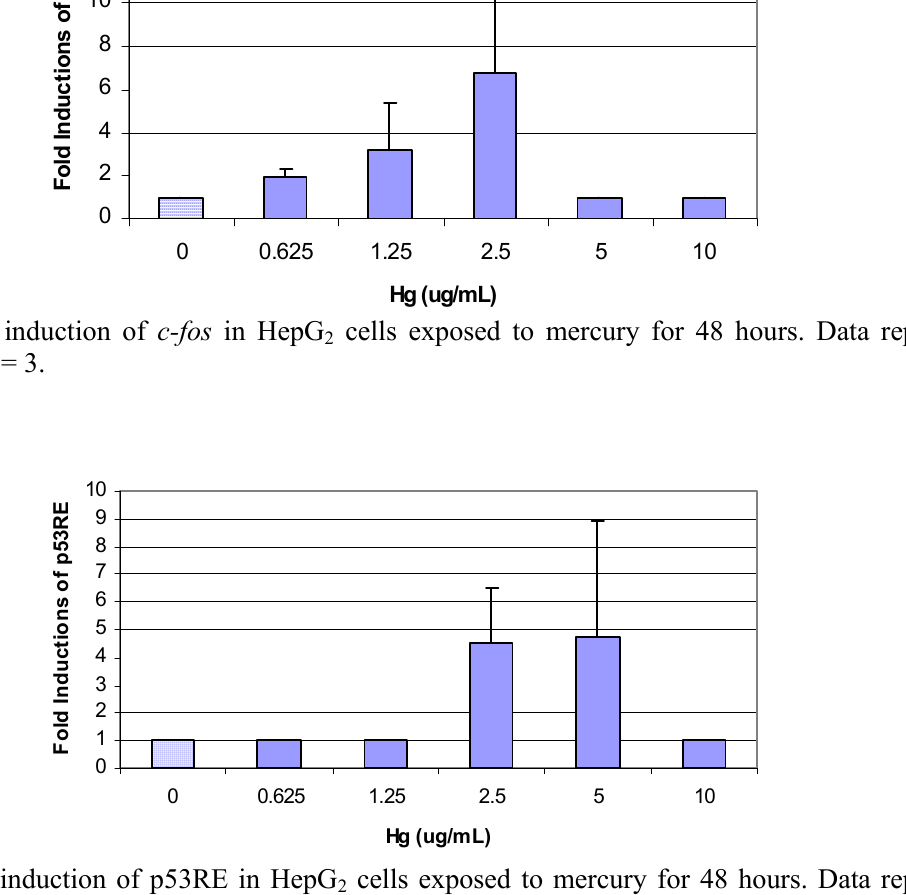
cells exposed to mercury for 48 hours. Data represent 2